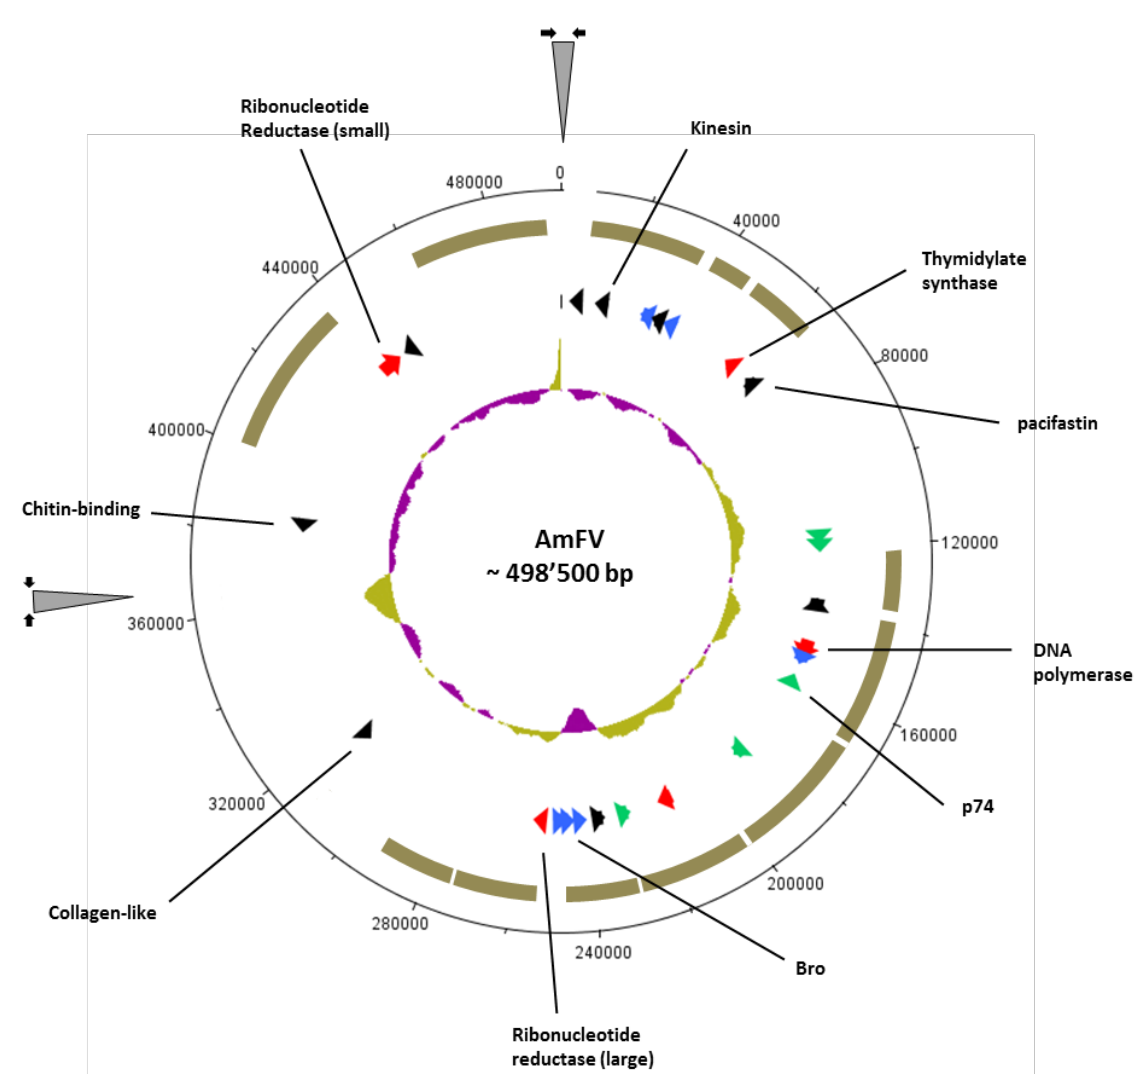
Figure 2. Schematic representation of the AmFV genome. Characteristic ORFs presenting similarities to other large dsDNA viruses are indicated. Colors refer to putative functions: DNA replication and nucleotides metabolism genes (red), pif and p74 homologs (green), Bro genes (blue), and putative virulence genes (black). The brown circle fragments correspond to the positions of the larger contigs (>8500 bp) filtered out from V. destructor metagenome assembly and assigned initially as baculovirus-like sequences [20]. The inner circle represents the GC plot (above average: gold; below average: purple). The grey triangles flanked by arrows indicate unresolved sequences.